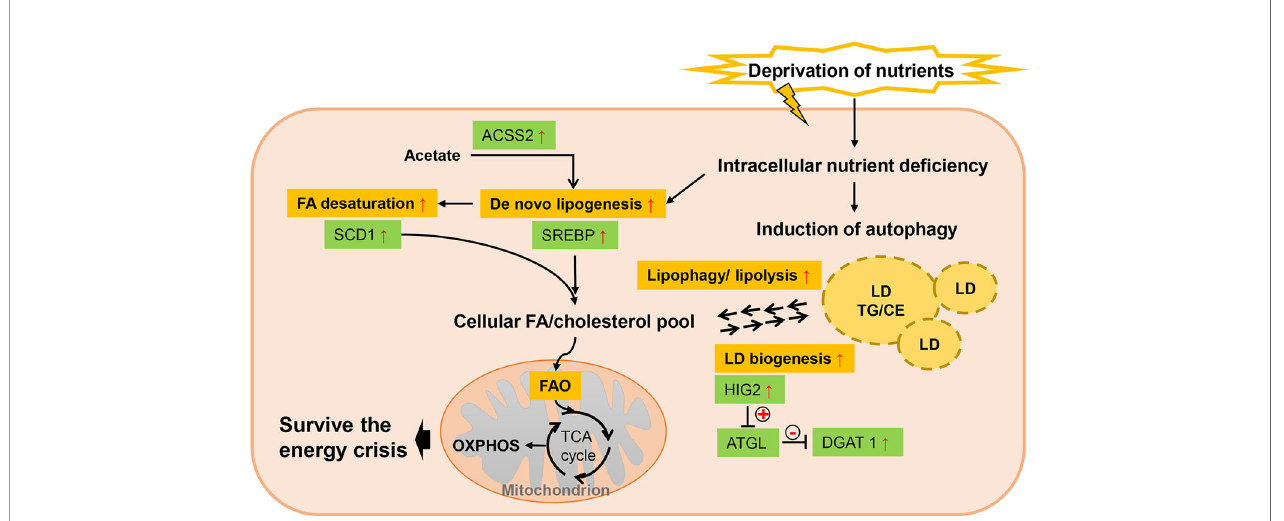
FIGURE 4 | Lipid metabolism reprogramming of cancer cells under nutrient deprivation. Low serum condition allows cancer cells to be more reliant on de novo lipogenesis for FA acquisition rather than exogenous uptake, which is mainly favored by elevated SREBP. As exogenous MUFAs supply is restricted, SCD1 is upregulated to maintain FA desaturation. Nutrient deprivation can induce autophagy in cancer cells and LDs are turned over to generate FAs through cytosolic lipolysis and autophagy-mediated lipophagy. But LD biogenesis is also induced in response to high autophagic fl ux, providing a lipid buffering system to alleviate lipotoxic cellular damage in autophagy. “ + ” in circle means positive effects and “ - ” in circle stands for